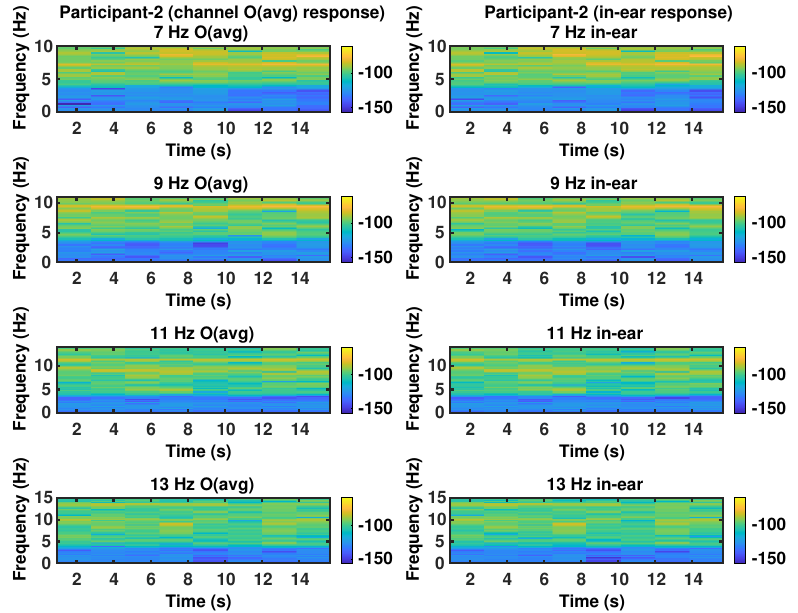
Figure 8. Spectrogram of participant 2 from occipital and in-ear electrode.